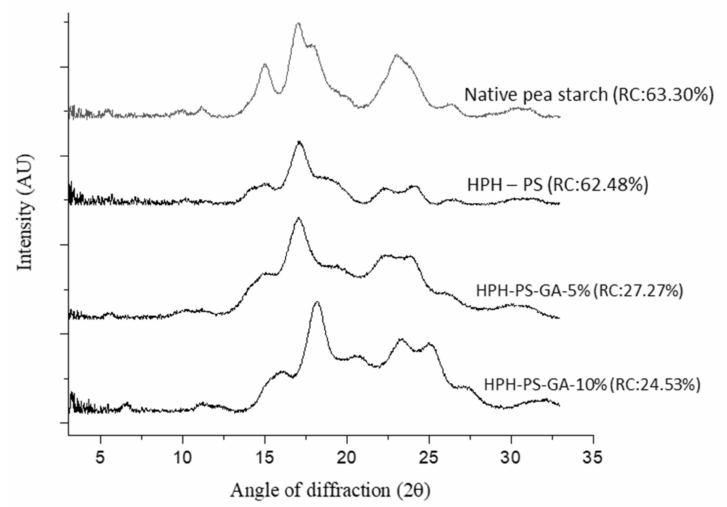
Figure 2. X-ray diffractograms of native and modified pea starch. HPH-PS: high-pressure homogenization- treated pea starch; HPH-PS-GA-5% and HPH-PS-GA-10%: high-pressure homogenization-treated pea starch with 5% and 10% gallic acid, respectively; RC: relative crystallinity.